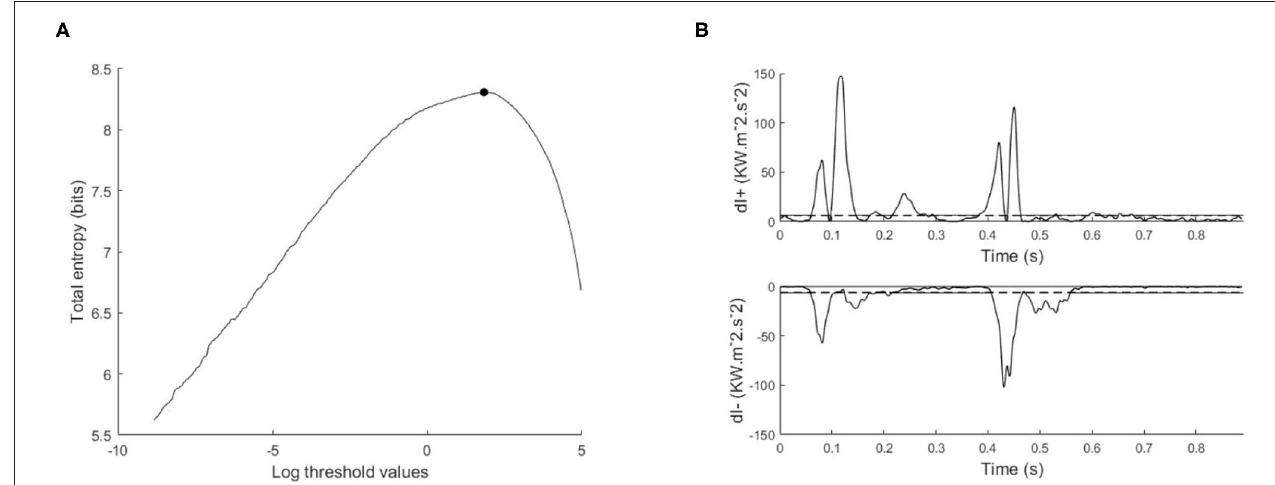
FIGURE 2 | Illustration of maximum entropy method and its application to the wave intensity signal, (A) total entropy as a function of the thresholds calculated on the log transformed data, with the optimal threshold indicated with a black circle, (B) separated wave intensity waveforms; forward ( dI + ) and backward ( dI − ). The horizontal dashed line is the exponential of the optimal